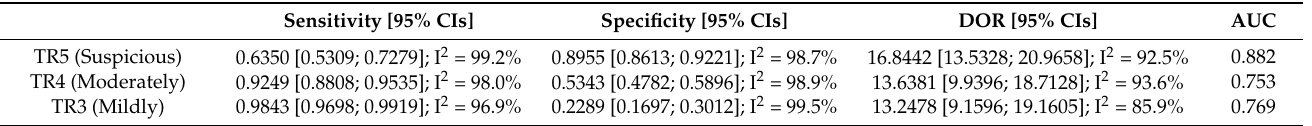
Table 2. Diagnostic efficacy and the ROC curves of ACR-TIRADS categories.